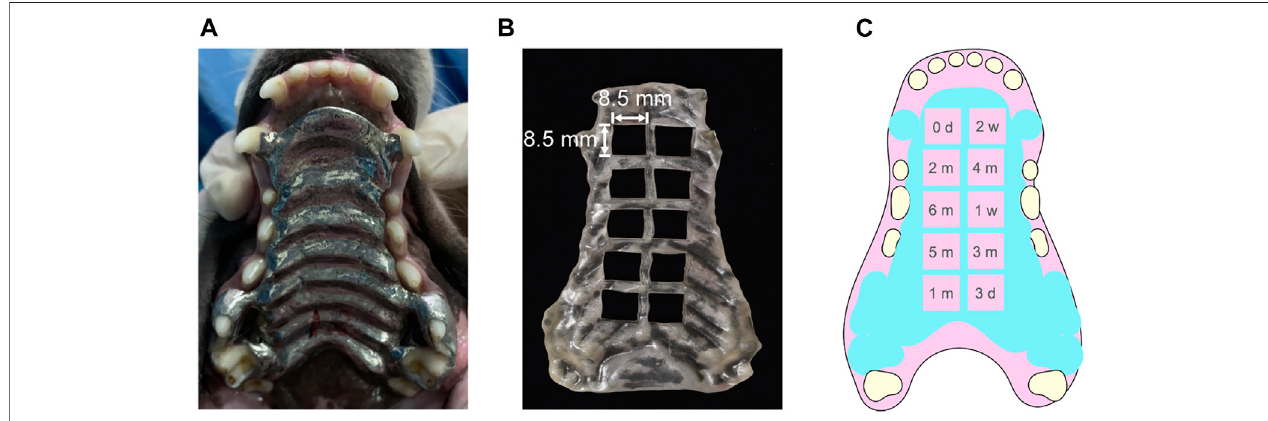
FIGURE 1 | (A) CAD/CAM metallic dental prosthesis, which was personalized by taking impression of the Beagle ’ s maxilla with silicone rubber, (B) 3-dimensional printed resin guide board for taking oral mucosa samples, and (C) schematic diagram of the order for taking oral mucosa samples.